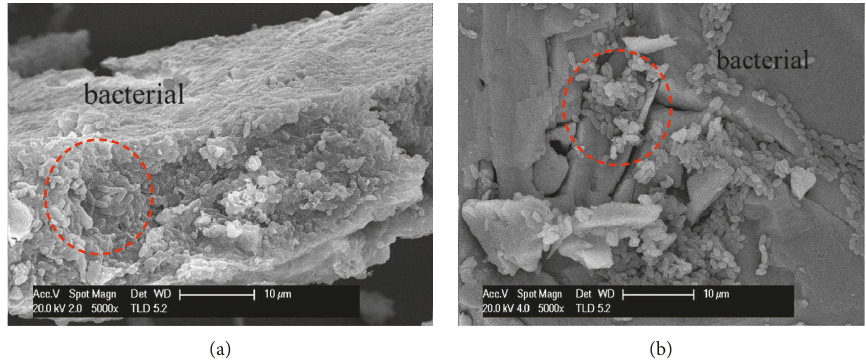
Figure 5: Calcium carbonate deposition induced by bacterial in the simulated pore solution of steel slag.